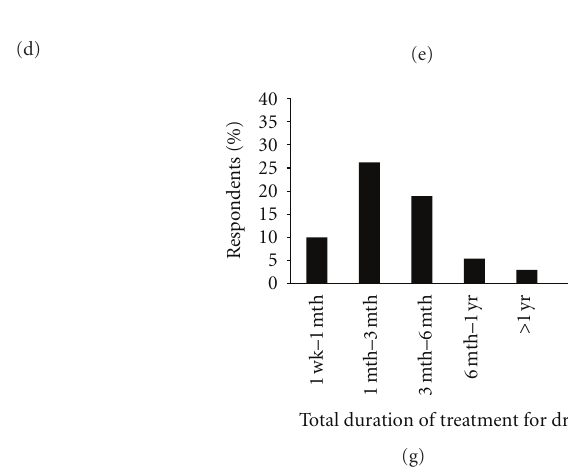
Figure 4: Practice of TCM practitioners in treatment of dry eye disease. Bar chart representing (a) modalities of TCM treatment that practitioners have used to treat dry eye. “Herbal medication” represents oral herbal decoctions or patent pills; “external treatment” refers to modalities such as hot compress and external herbal wash and eye drops refer to conventional topical eye drops, (b) charges for acupuncture treatment per session, (c) charges for nonacupuncture TCM treatment per session, (d) period of time from the last TCM treatment of a dry eye patient, (e) average number of dry eye patients treated per week by TCM practitioners, (f) frequency of TCM treatment and follow-up visits for dry eye patients, and (g) entire span of TCM treatment course for dry eye patients. Wk: week, Mth: month. All charges are in Singapore